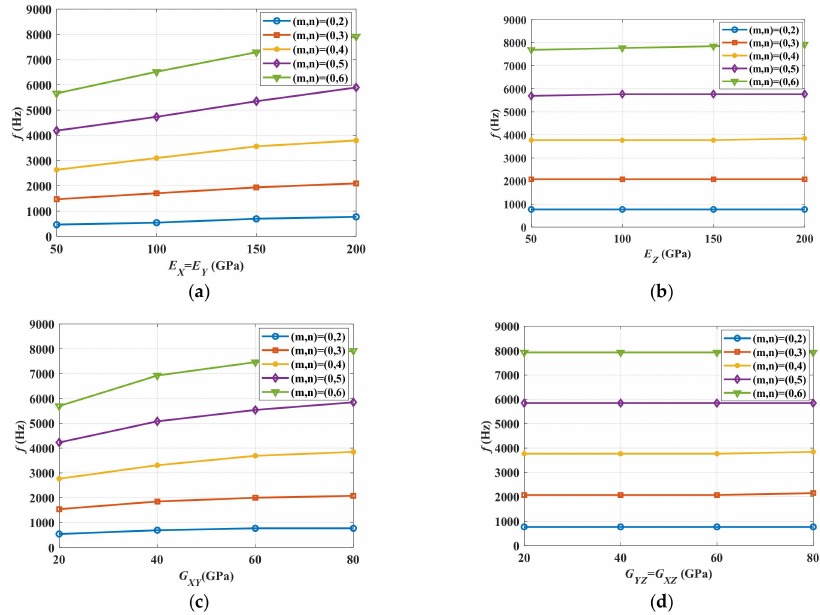
Figure 2. Anisotropic material property influence on stator core modal frequency of m = 0. ( a ) Effects of E X and E Y ; ( b ) Effects of E Z ; ( c ) Effects of G XY ; ( d ) Effects of G YZ and G XZ .